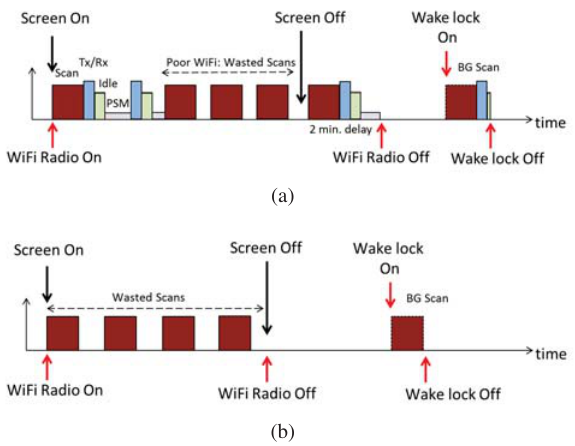
Figure 1: Working of default Wi-Fi when (a) an AP is available to connect with, and (b) an AP is not available.